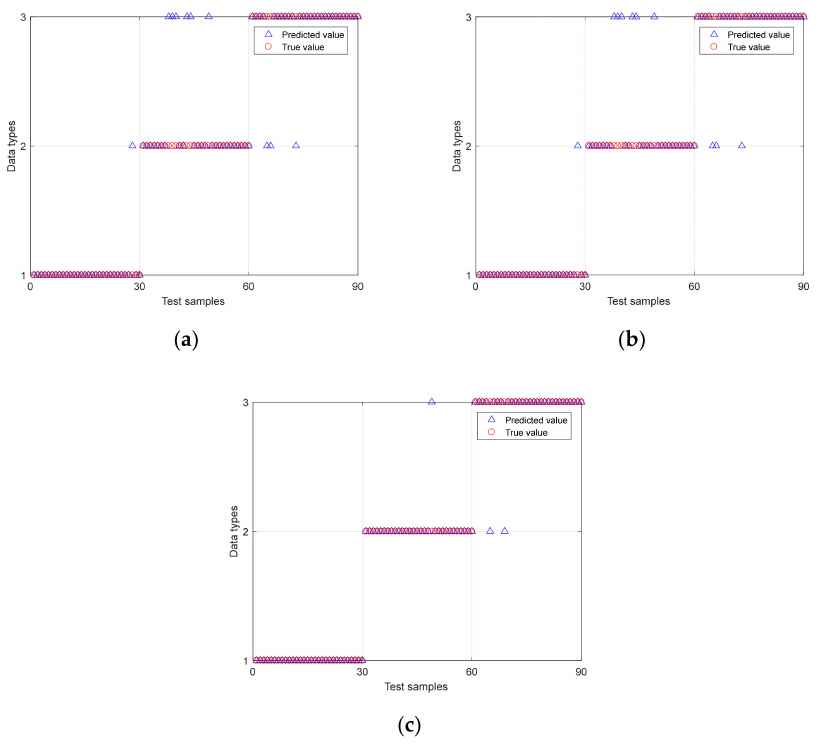
Figure 8. The damaged recognition results of biological tissue based on MSE-PNN, MPE-PNN and IMWPE-PNN. ( a ) MSE-PNN; ( b ) MPE-PNN; ( c )